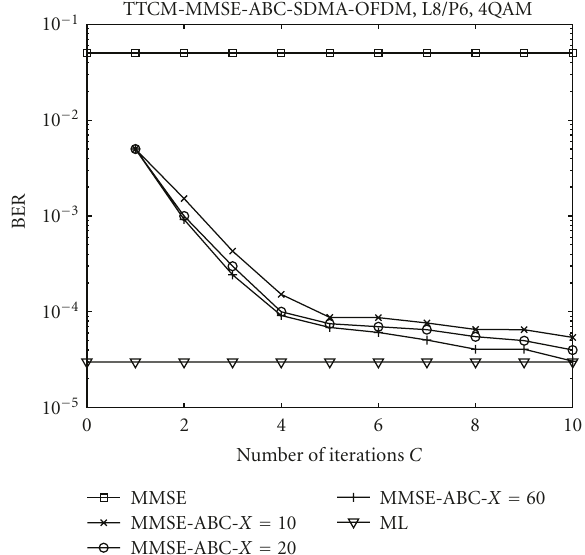
Figure 9: BER versus number of iterations performance with the population size fixed at X = 10, 20 and 60 for 8 × 6 system.